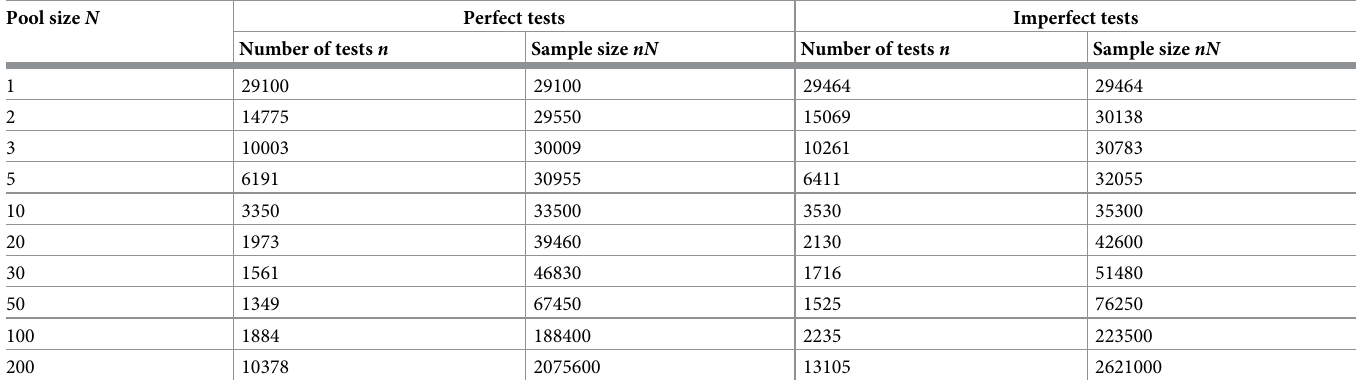
Table 3. Table of the pool size as a function of the number of tests for a prevalence of 3% measured with a precision of 0.2% at a 95% confidence interval, for both perfect tests (with no false negatives, see Sec III.1) and imperfect tests (with false negatives estimated using the Jones et al. dataset; model parameters defined in Table 2); computed using Eqs 17 and